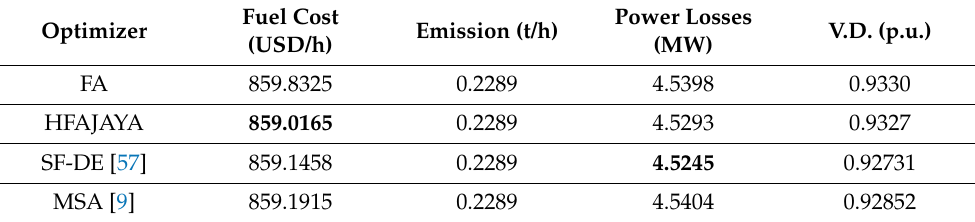
Table 6. The obtained optimal results in the current works for Case 4.